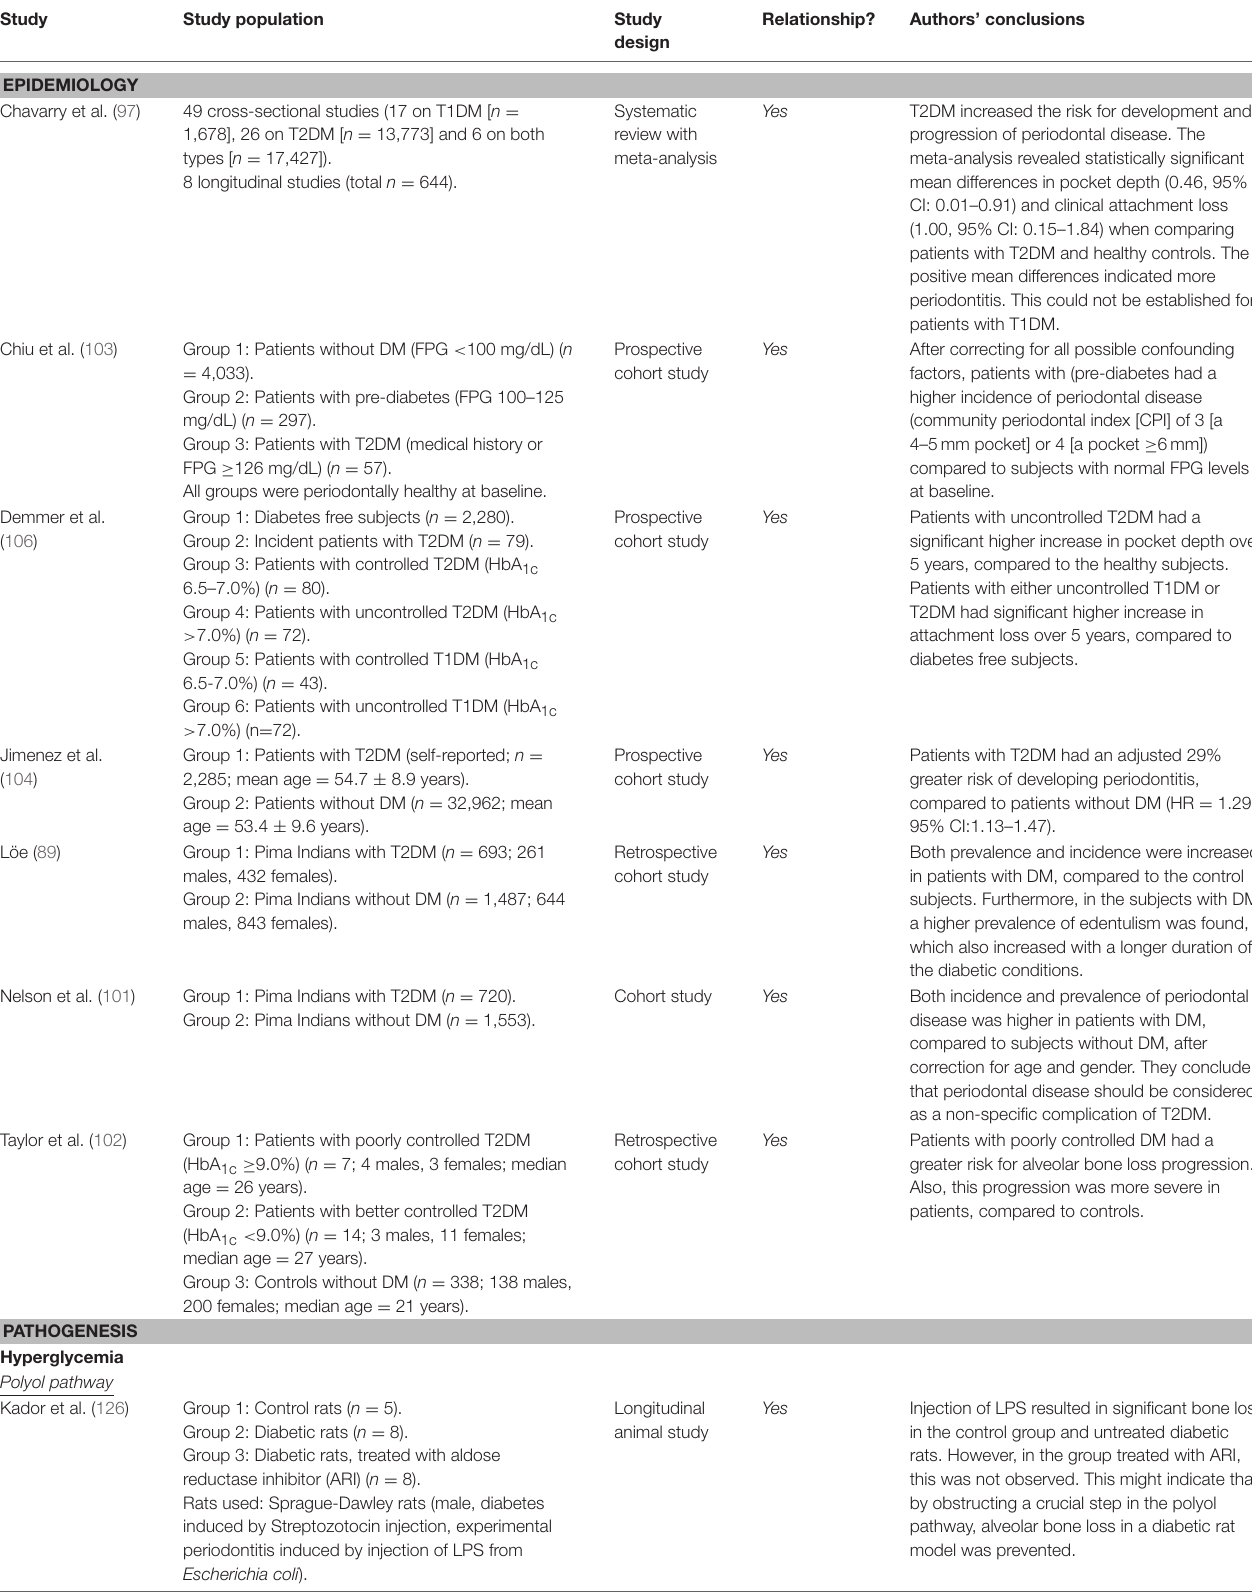
TABLE 1 | Overview of studies investigating the association between diabetes mellitus and periodontal disease.